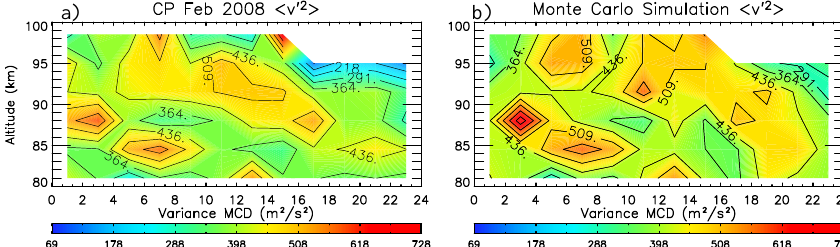
Fig. 17. (a) Meridional variance for Cachoeira Paulista on February 2008 without the measurements uncertainties contribution. (b) The same as (a) but including the error contribution in a Monte Carlo simulation with 15000